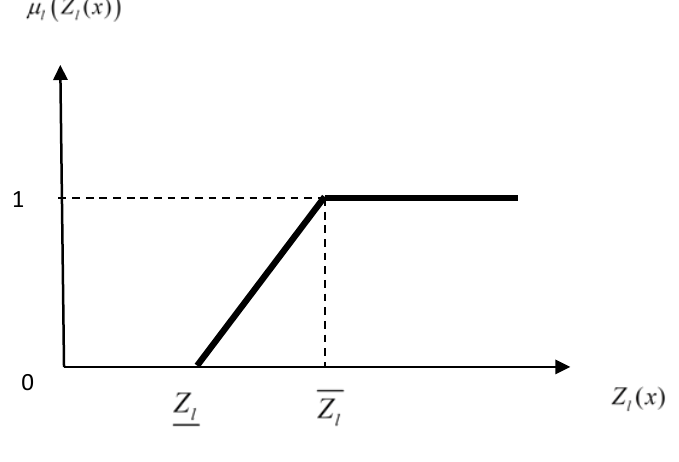
Fig. 1. Membership function